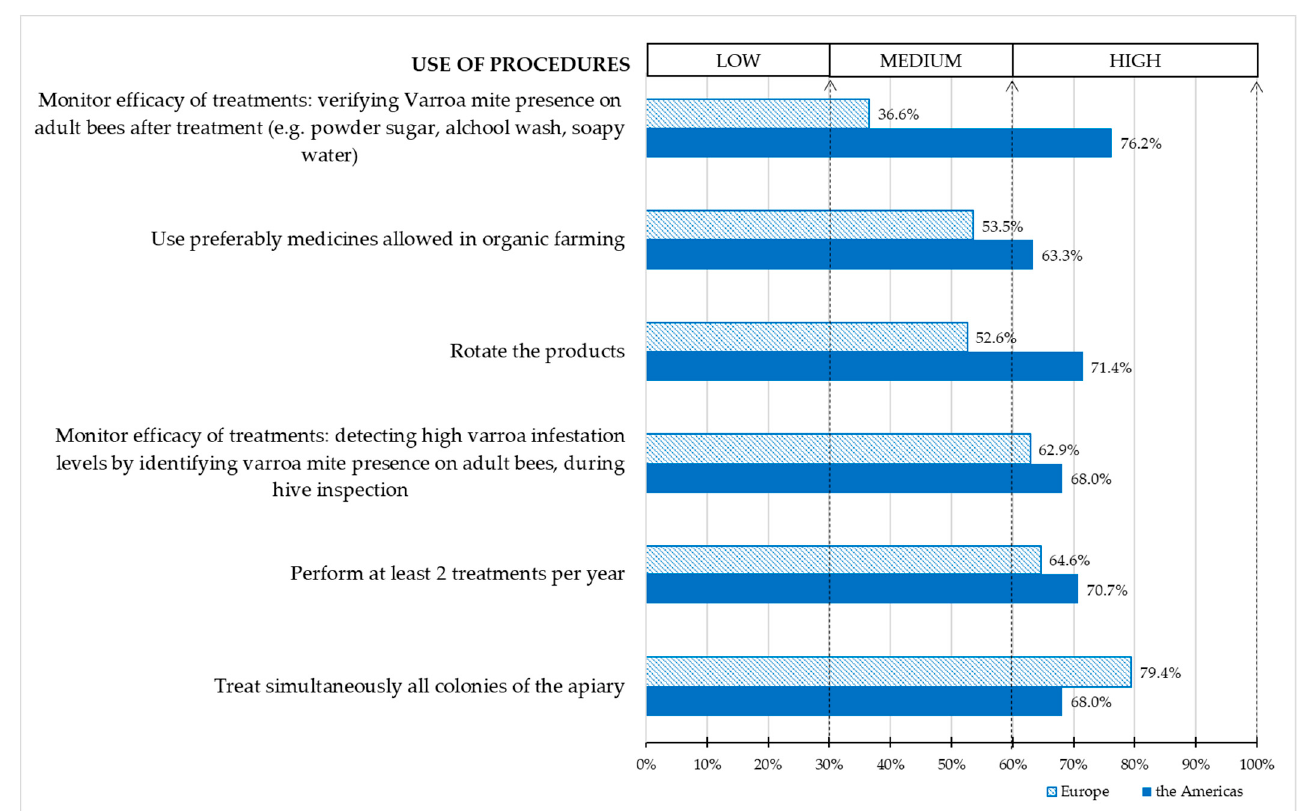
Figure 4. Willingness to accept the listed biosecurity measures by Americans (full blue) and European (blu strips) beekeepers.